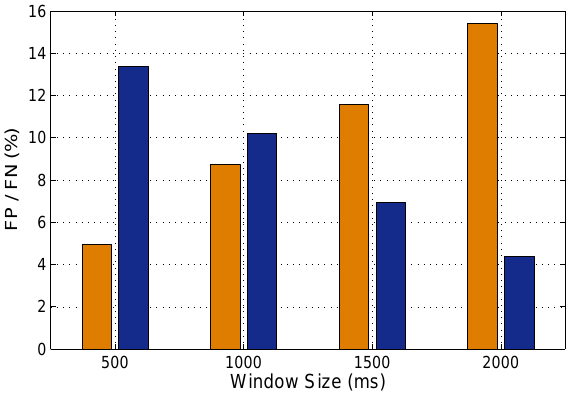
Figure 12. FN and FP of